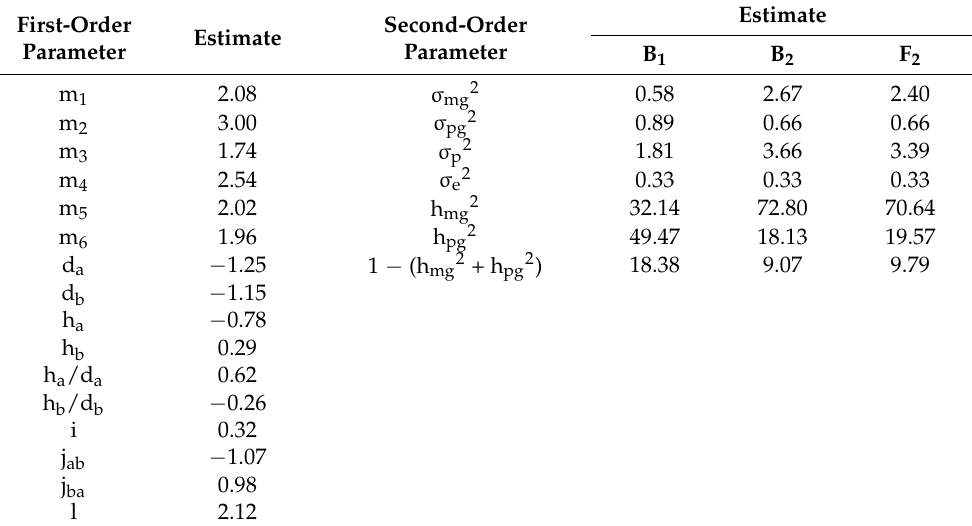
Table 5. The estimation of genetic parameters of fit a model of CFW